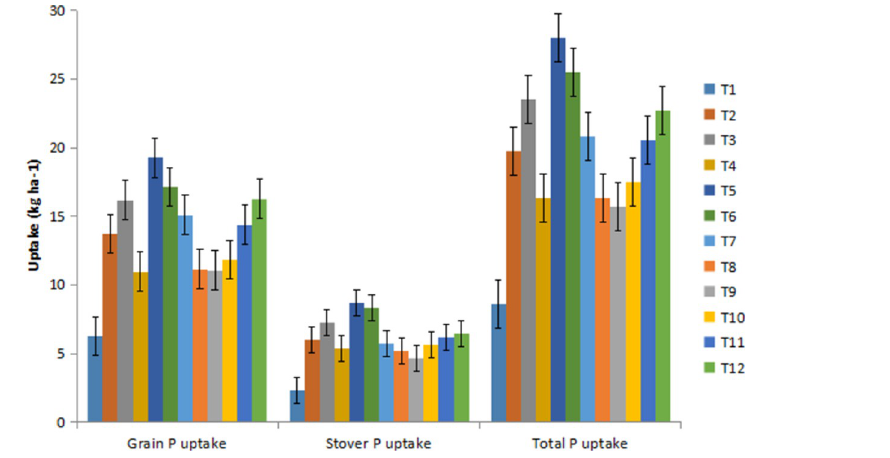
Fig 2. Phosphorous uptake in chickpea under various INM modules.